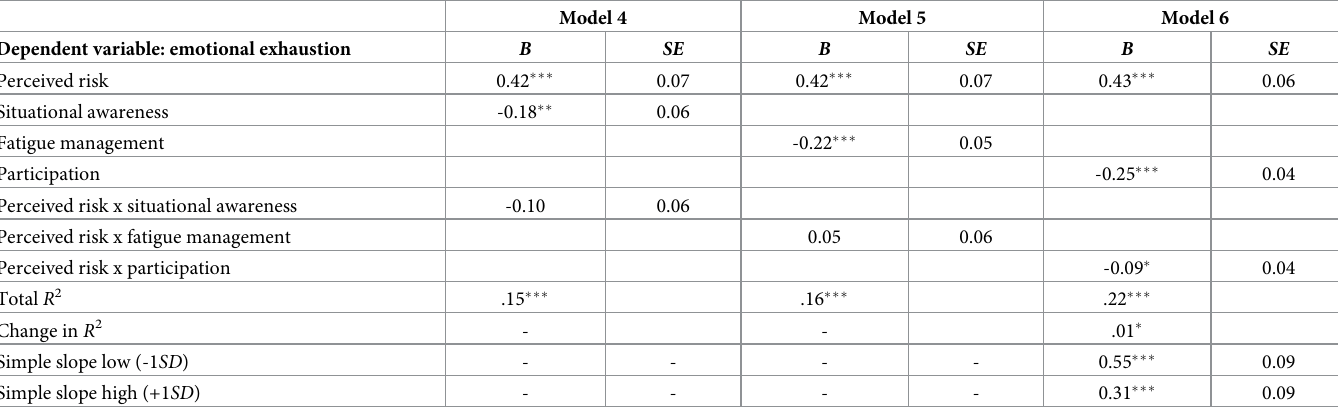
Table 3. Results from moderated multiple regression analyses: Model 4, Model 5, and Model 6 ( N =